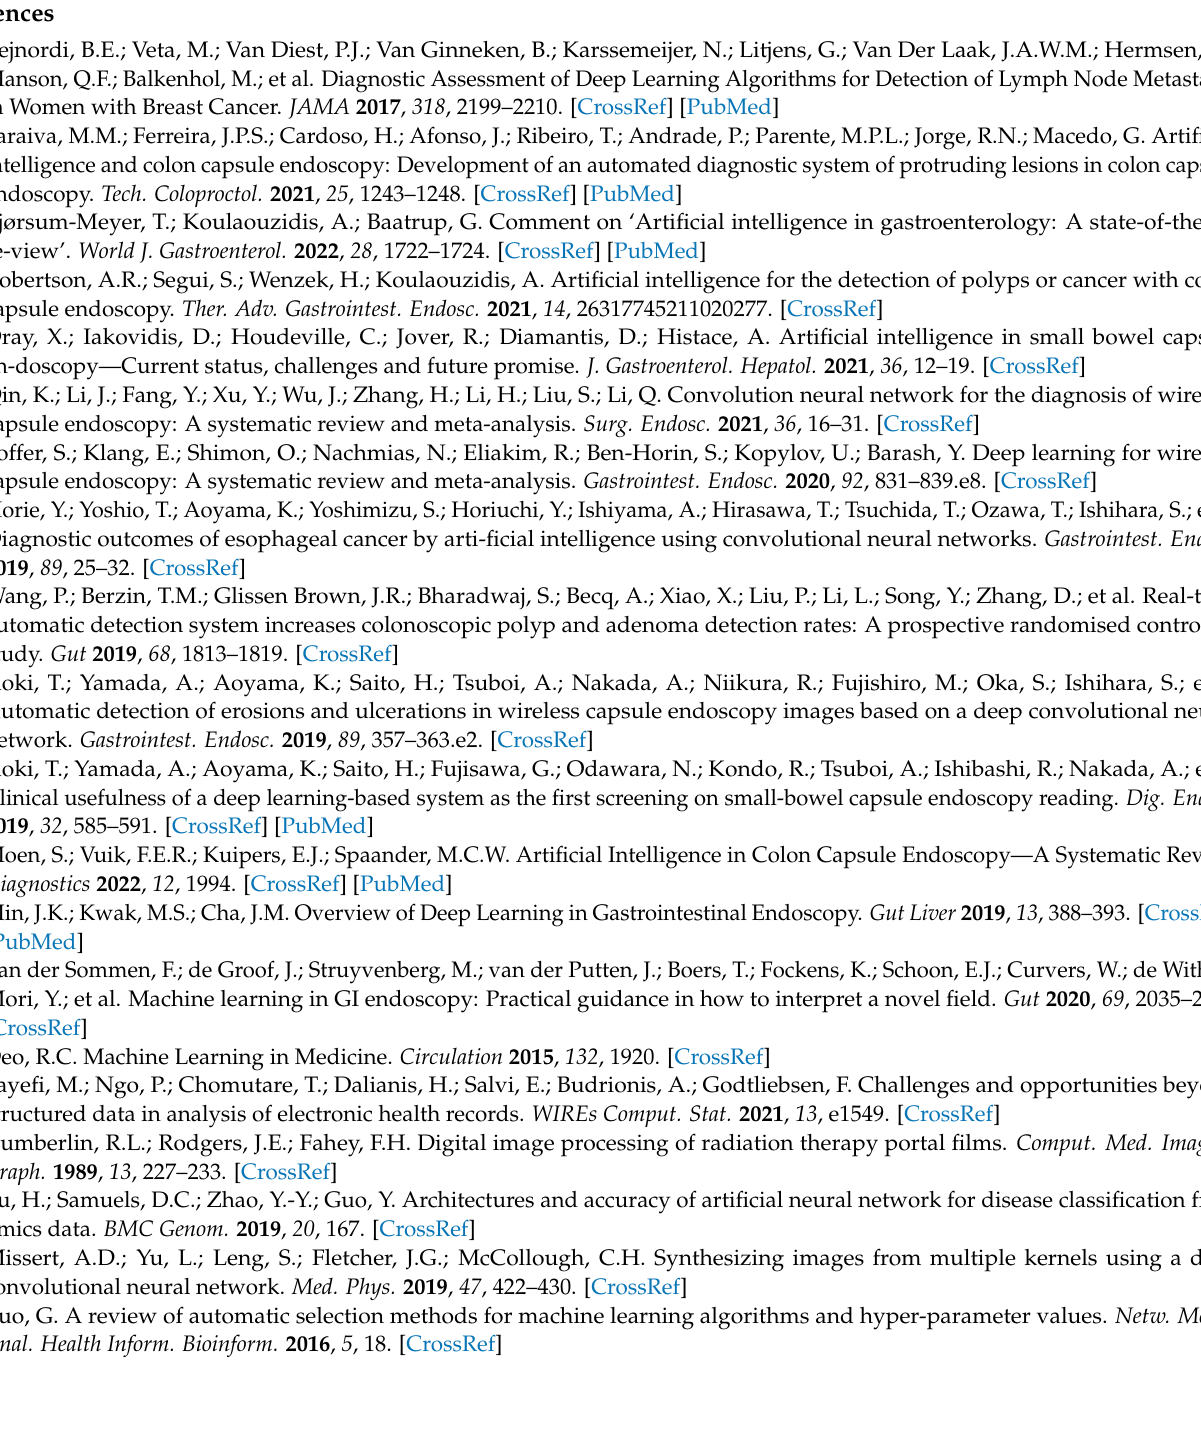
Figure A2. The intrinsic method or behaviour of the AI code in the model is uninterpretable, like a black box with no transparency.